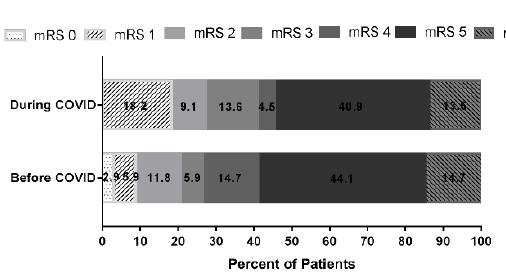
Figure 4. Functional outcomes at 3 months from onset according to the Modified Rankin Scale Score. During COVID ( n = 28); pre-COVID ( n = 34). Favorable outcome as defined by a modified Rankin Scale (mRS) score less than or equal to 2 at 3-month follow-up. The rate of mRS score after MT three months ≤ 2 score presented that pre-COVID-19 group was 21.4%, compared to 27.3% during COVID-19 group.